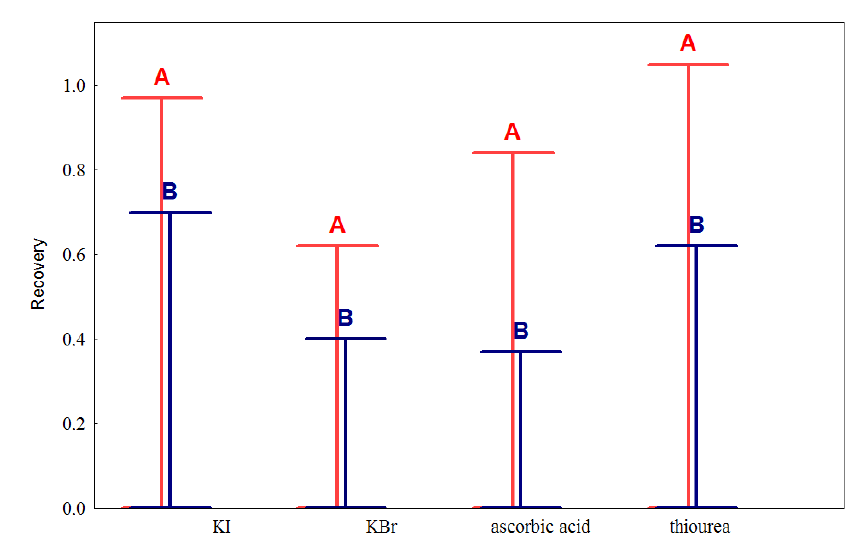
Fig. 4 Comparison of performance of different reducing agents: A – 0.5 mL + 1 mL HCl B – 0.5 mL + 0.5 mL